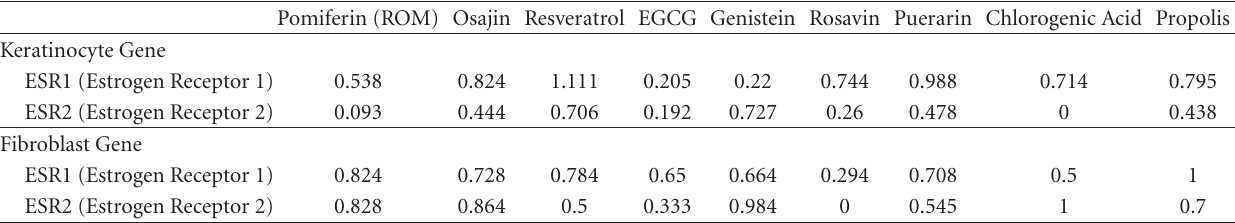
Table 7: Summary of Ratio of Medians for ingredient influences on estrogen receptor gene